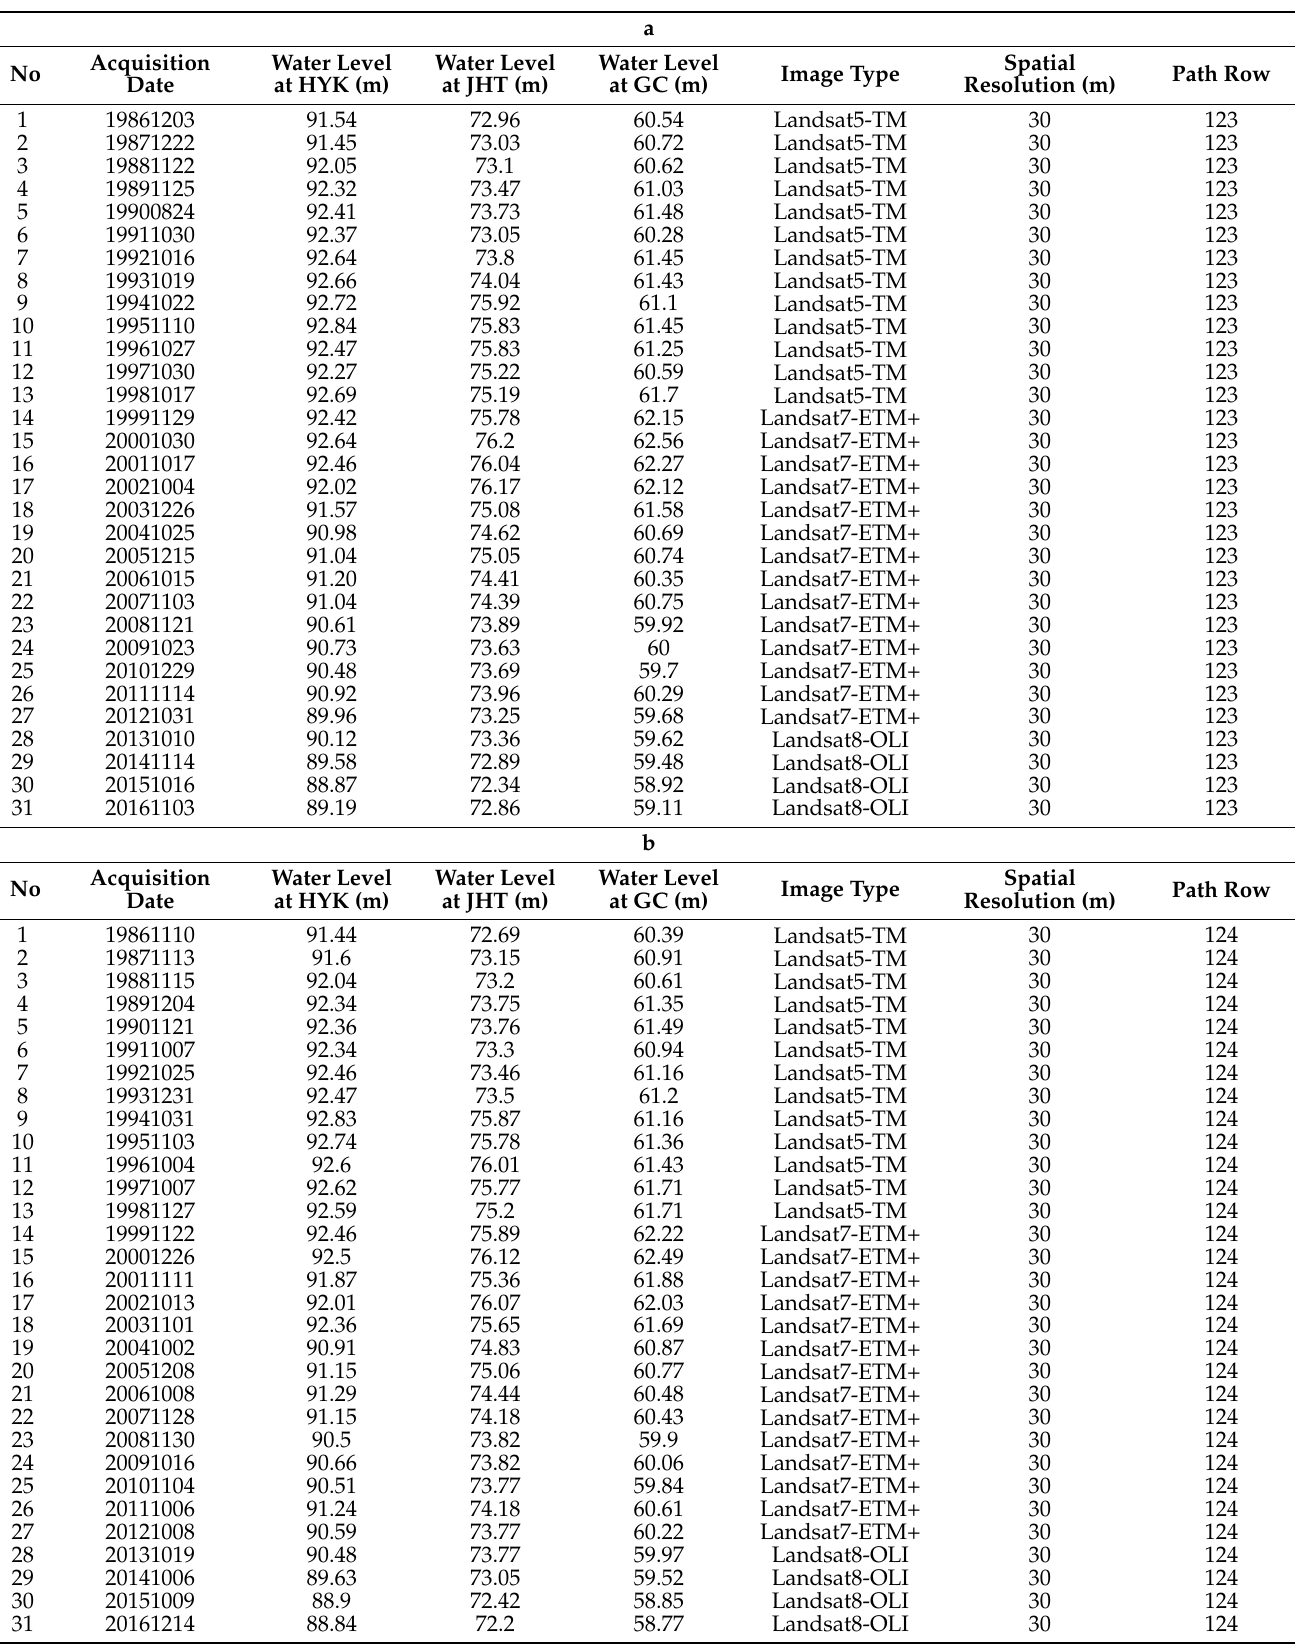
Table 1. ( a ) Characteristics of the selected satellite images (Path Row is 123). ( b ). Characteristics of the selected satellite images (Path Row is